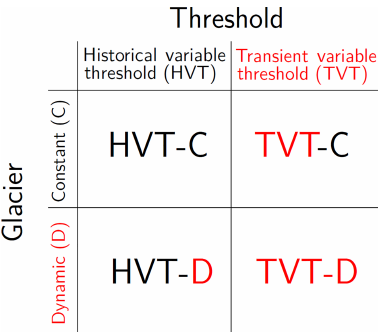
Figure 3. Four analysis scenarios. The matrix shows the combina- tion of the two threshold approaches with the two different glacier area conceptualisations, resulting in four possible combinations. The baseline options are indicated in black and the options where changes are taken into account are shown in